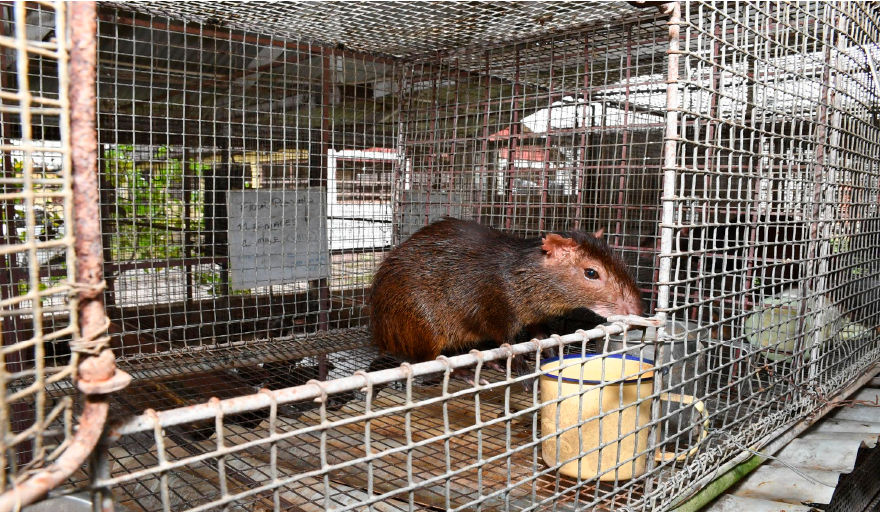
Figure 1. Photograph showing D. leporina in a cage housing at the Neotropical Wildlife Unit at University Field station.